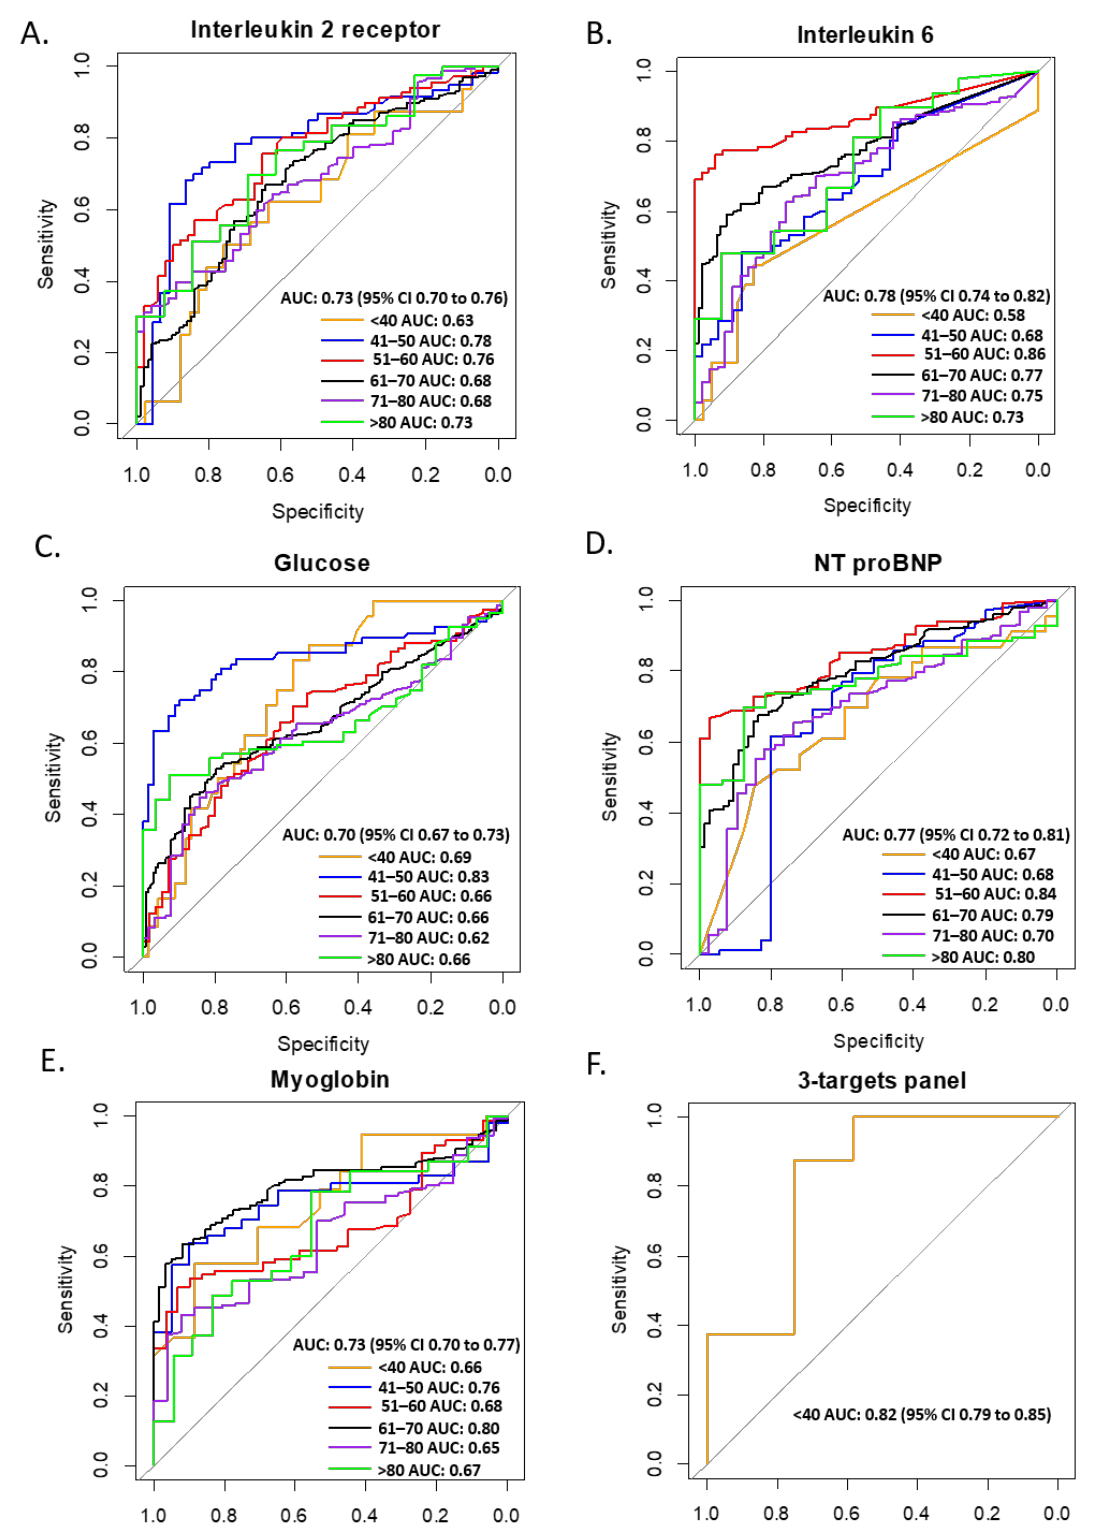
Figure 3. Receiver Operating Characteristic (ROC) curves for Interleukin 2 receptor ( A ), Interleukin 6 ( B ), glucose ( C ), NT proBNP ( D ), myoglobin ( E ), and three-target panel ( F ) for identifying individuals with severe COVID-19. AUC, area under the curve; CI, confidence interval; NT proBNP, N-terminal pro brain natriuretic peptide.